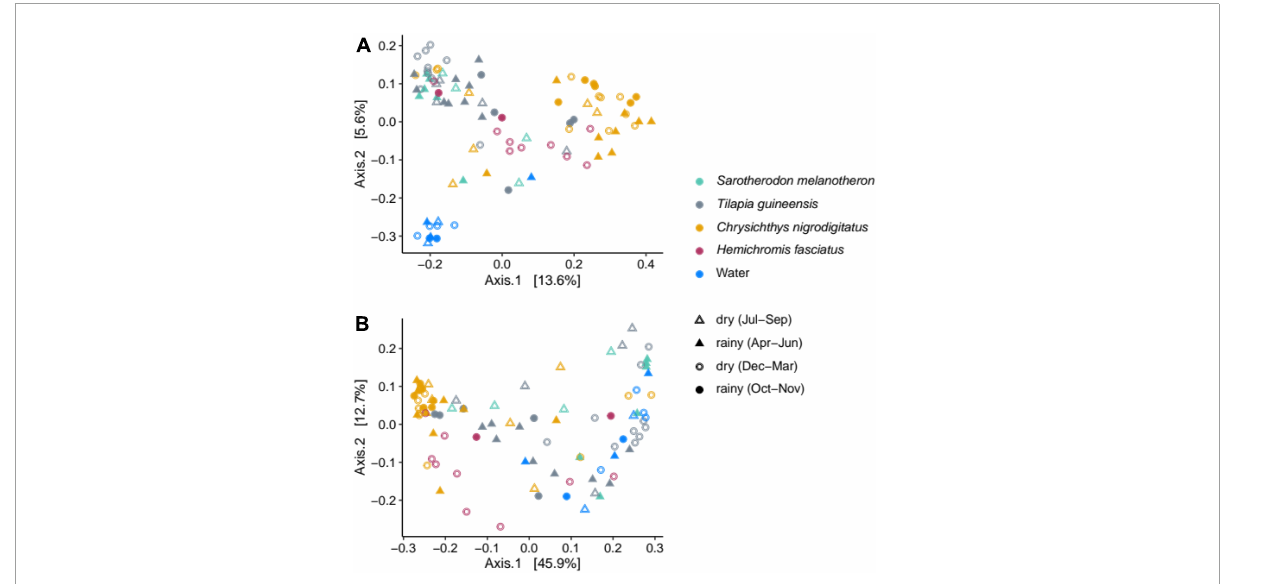
FIGURE4 Principal coordinates analyses based on the unweighted (A) and weighted (B) UniFrac distances, illustrating the bacterial compositions from water and fish gut samples according to the different seasons over the year (dry or